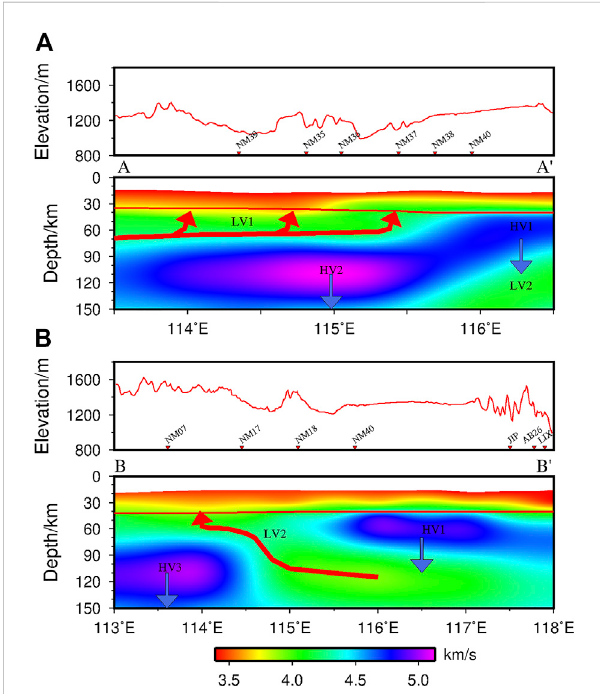
FIGURE 9 TerrainElevationandS-velocitymapplottedalongthePro fi leAA ’ and BB ’ (A, B) . The positions of the pro fi les are shown in Figures 1, 4, and8.TheredcurveintheS-wavevelocitypro fi leisMohosurface(He et al., 2018). The blue and red arrows represent the direction of lithosphericdelaminationandhotmaterialupwellingrespectively.The long period surface-wave datap have poor resolution on the velocity structure of the shallow crust and the shallow surface. Therefore, the inversion results of the fi rst layer depth range of CRUST1.0 model at each node in the pro fi le are removed without further